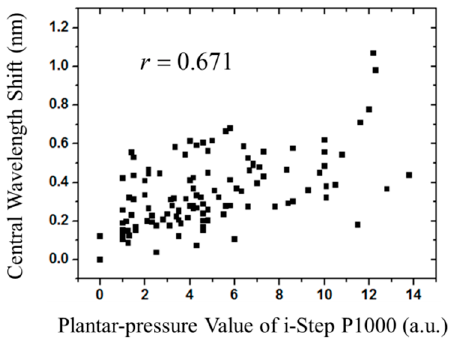
Figure 13. The central wavelength shift of six FBGs corresponding to the plantar pressure value of i-Step